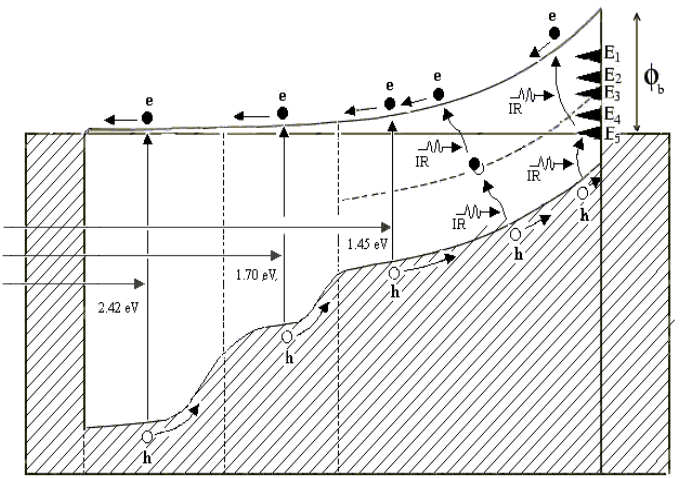
Figure 14. The energy band diagram of the 3-layer glass/CG/CdS/CdSe/CdTe/metal solar cell with an intermediate CdSe layer. During an annealing and aging process, this structure becomes a multi- layer graded bandgap tandem solar cell due to intermixing of materials at two hetero-junctions [31].